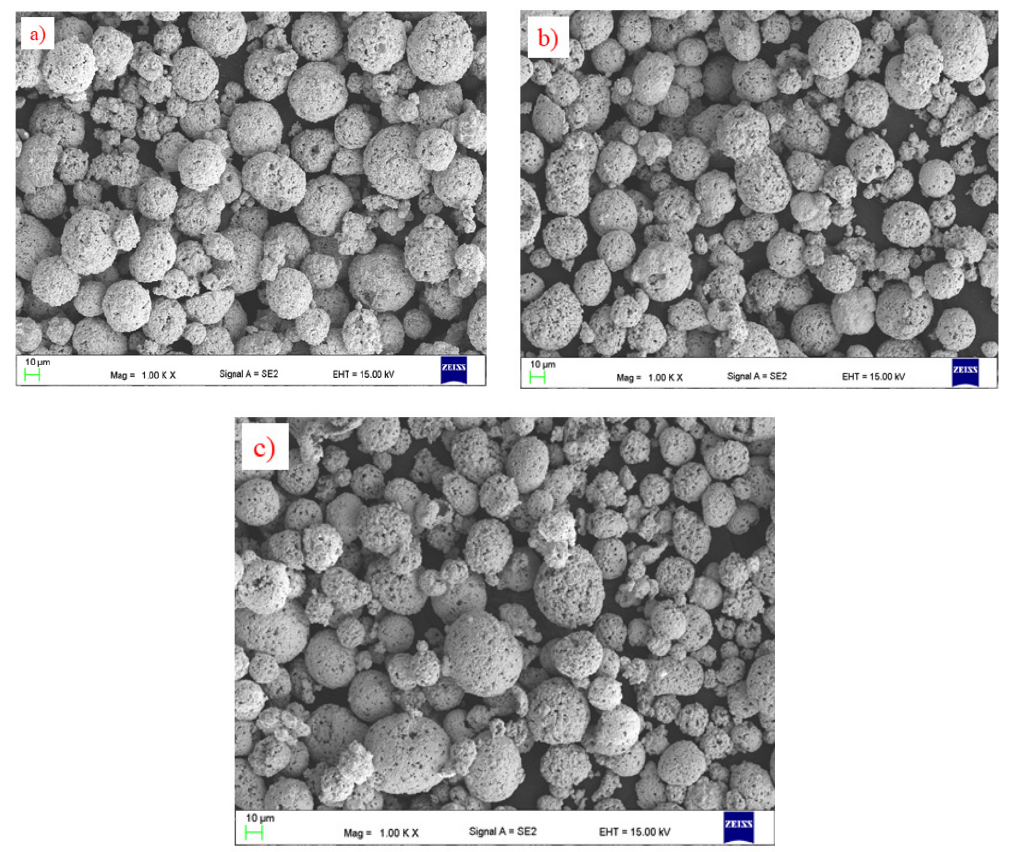
Figure 2. Morphology of: ( a ) P1, ( b ) P2, and ( c ) P3 powder (SEM).